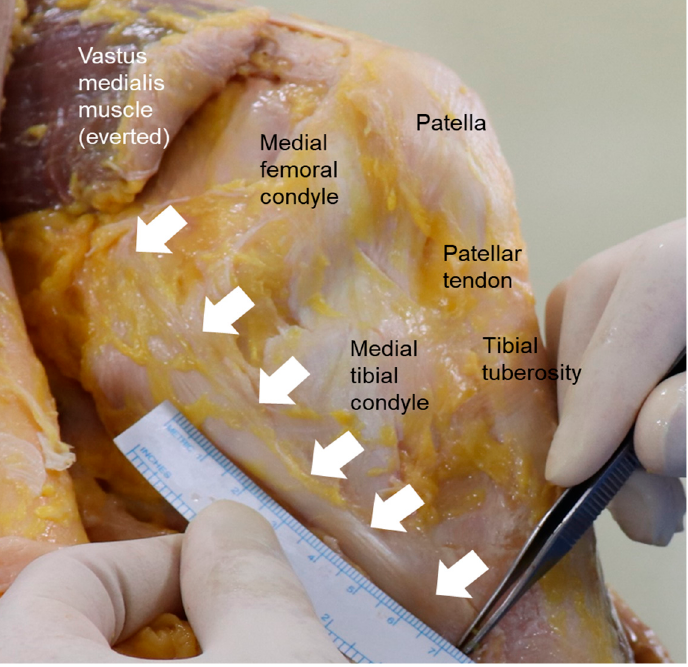
Figure 1. Anatomy of the medial collateral ligament (white arrows) and its surrounding structures. The MCL is the largest ligamentous structure on the medial aspect of the knee joint, with a length of 90–110 mm, and consists of both superficial and deep components. The sMCL is a broad ligament composed of fibers that originate proximally from the medial femoral condyle, 1 cm anterior and distal to the adductor tubercle, and runs distally to the anteromedial aspect of the tibial crest, approximately 4.5 cm distal to the joint line posterior to the pes anserinus [6,7]. The dMCL, which is also called the midthird capsular ligament, is a thickening of the medial joint capsule that is made up of distinct meniscofemoral and meniscotibial portions. The posterior border of the dMCL blends along the central arm of the POL to form the posteromedial capsule. The meniscofemoral ligament is longer than the meniscotibial ligament, and originates from the femur, just distal to the sMCL origin, and inserts into the medial meniscus (MM). The meniscotibial ligament, which originates from the MM and attaches to the medial tibial plateau, is thicker and shorter